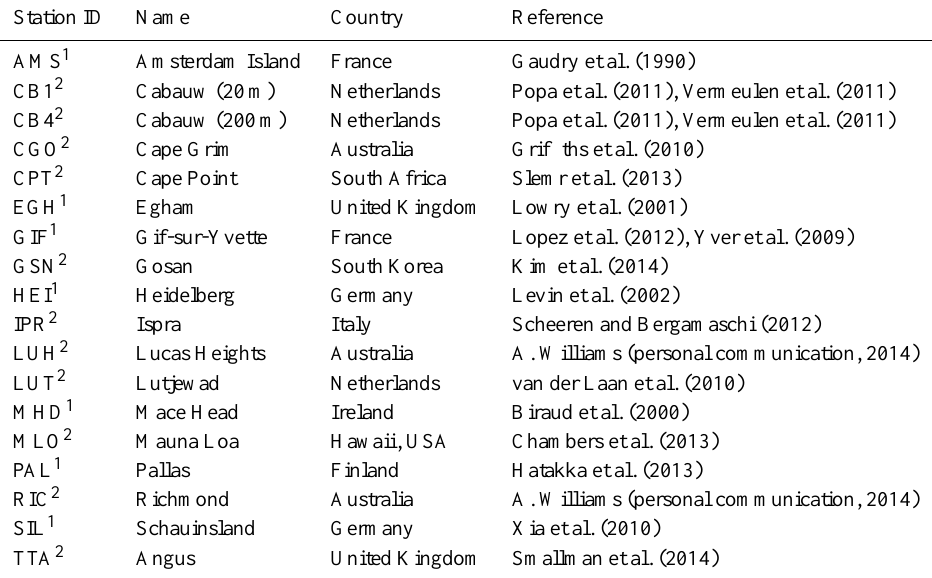
Table 2. Description of the different surface stations used for the evaluation of 3-D simulations of 222 Rn. Station